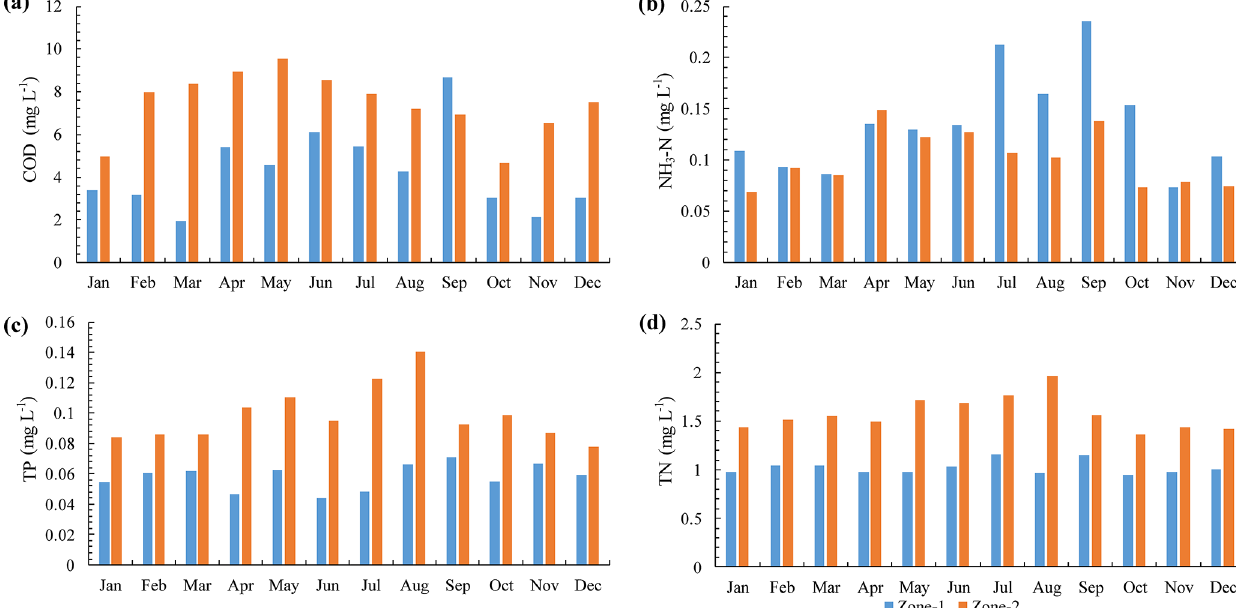
Figure 17. Average water quality changes in zone 1 and zone 2. (a) Variation in chemical oxygen demand; (b) variation in ammonia nitrogen; (c) variation in total phosphorus; and (d) variation in total nitrogen. The blue bar represents zone 1, and the orange bar represents zone